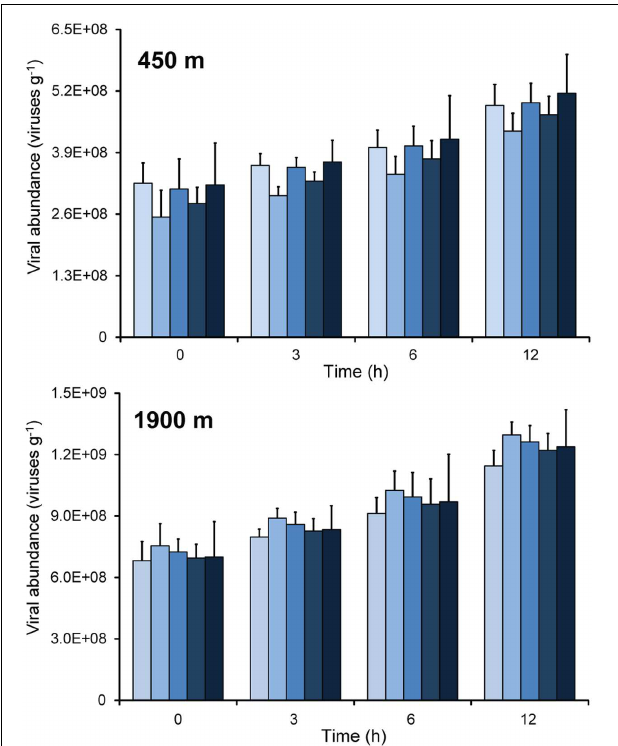
FIGURE 1 | Changes of viral abundance during time course incubation experiments carried out on sediment samples collected at the two benthic deep-sea sites (at 450 and 1900 m water depth). The bars refer to, from light to dark blue: sediments diluted 1:1, 1:5, and 1:10 times; homogenized and undiluted; intact sediment cores. Mean values ( n = 3) and SDs are reported.